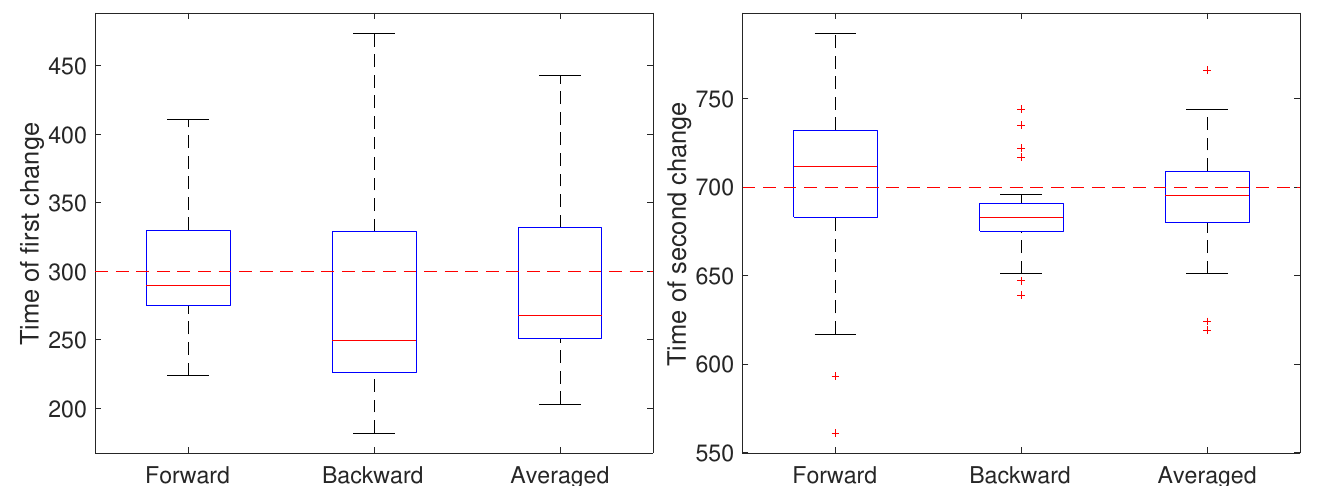
Figure 6. Detected time of change under a low noise setting based on using only the forward pass, only the backward pass, or averaging the two for the ( left ) first change (at k = 300) of the diffusion coefficient from 0.05 to 0.2 µ m 2 /s and the ( right ) second change (at k = 700 ) back to 0.05 µ m 2 /s.